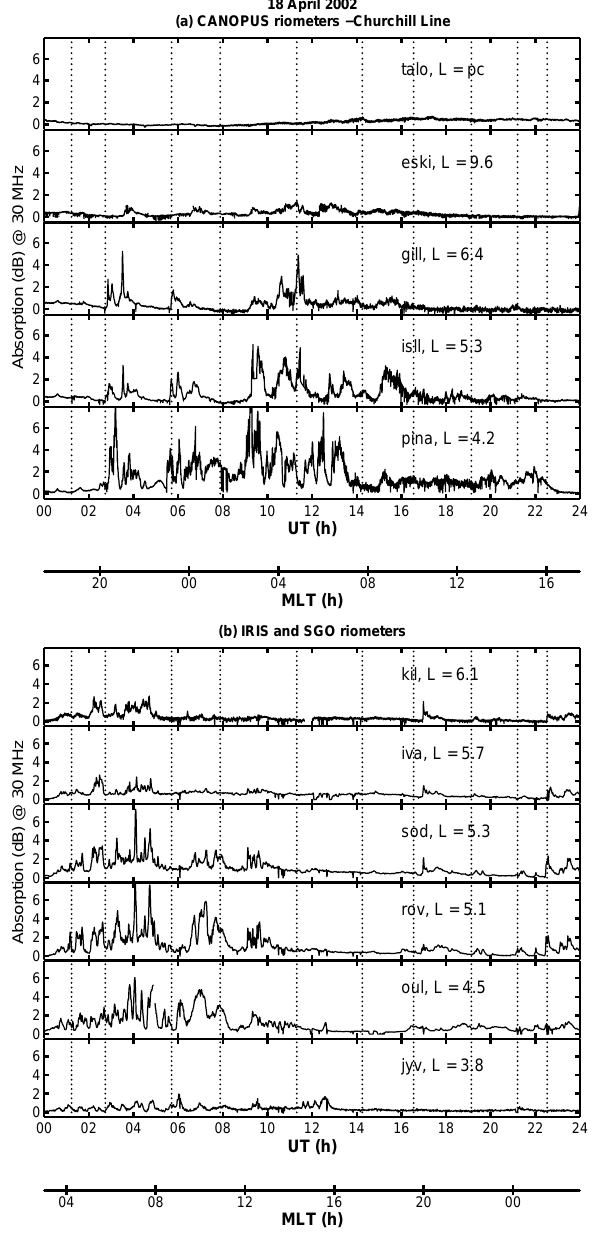
Fig. 4. (a) Cosmic noise absorption (CNA) from five of the Churchill line riometers. Corresponding L-shells are labelled; pc refers to “polar cap” where Taloyoak (talo) is on open field lines. The second x-axis demonstrates the average magnetic local time for the five riometers. (b) CNA from IRIS (kil) and the SGO riome- ters in the Finnish sector. All values of decibels (dB) are given for 30MHz.